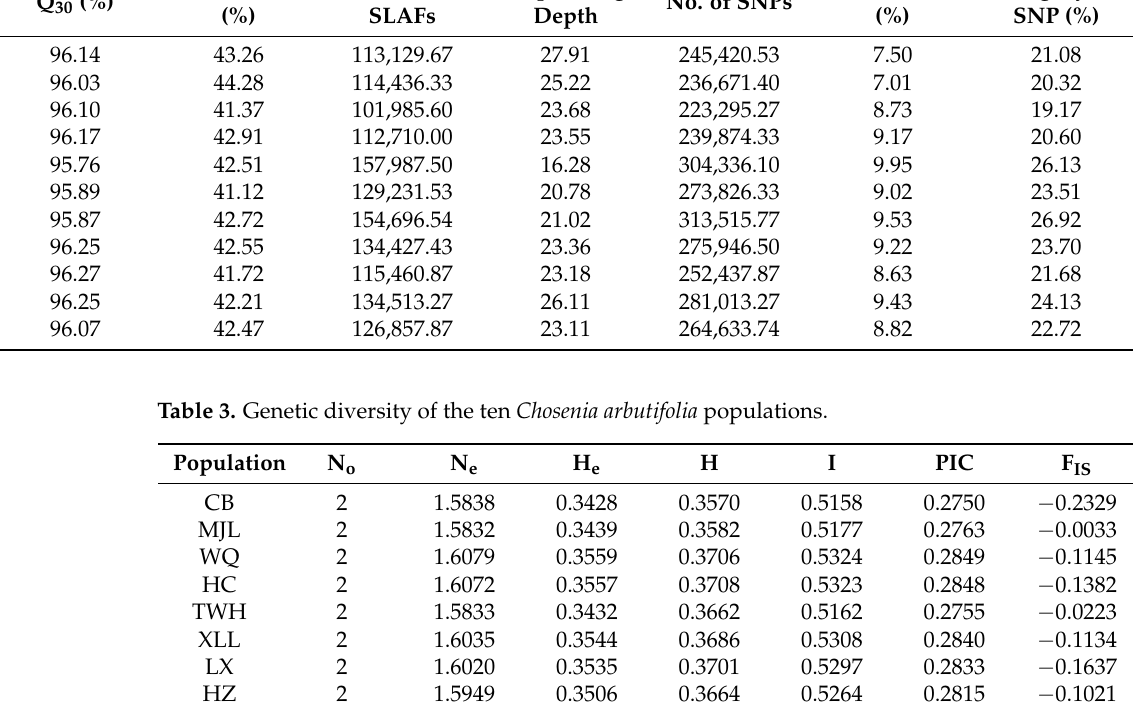
Table 2. Statistics of SLAF tags and SNP markers for different provenances of Chosenia arbutifolia (Pall.) A. Skv. Provenances